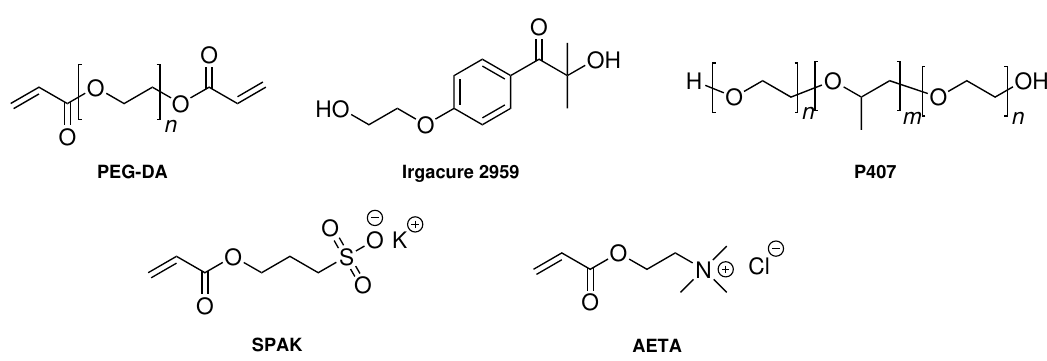
Figure 1. Structures of poly(ethylene glycol) diacrylate (PEG-DA), Irgacure 2959, Poloxamer 407 (P407), sulfopropyl acrylate potassium salt (SPAK), and [2-(acryloyloxy)ethyl]trimethylammonium chloride (AETA).